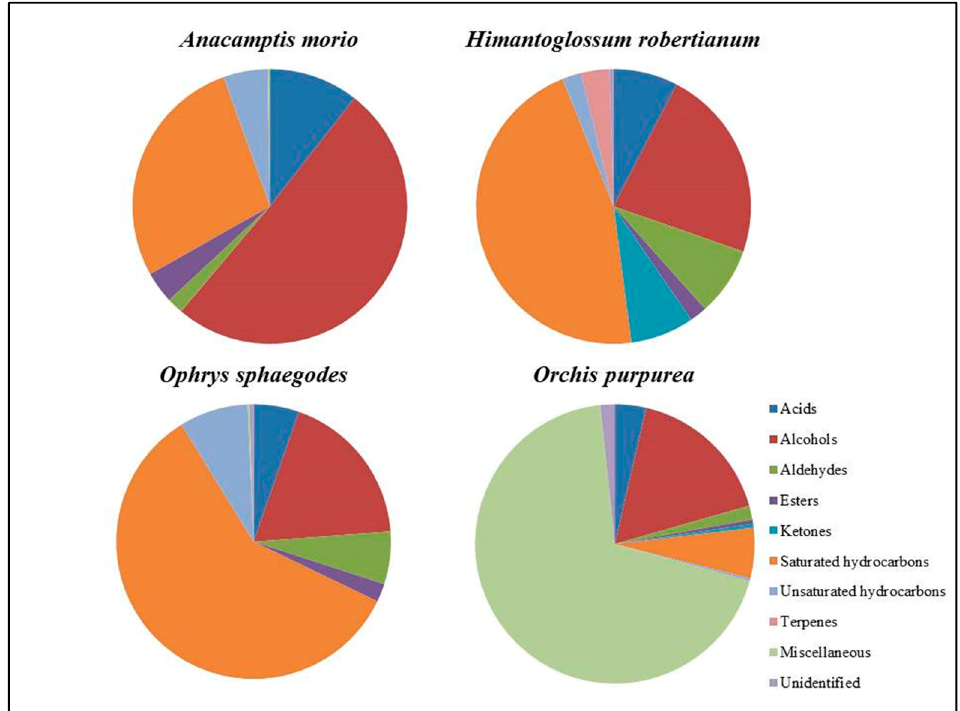
Figure 2. Pie chart of distribution of the classes.